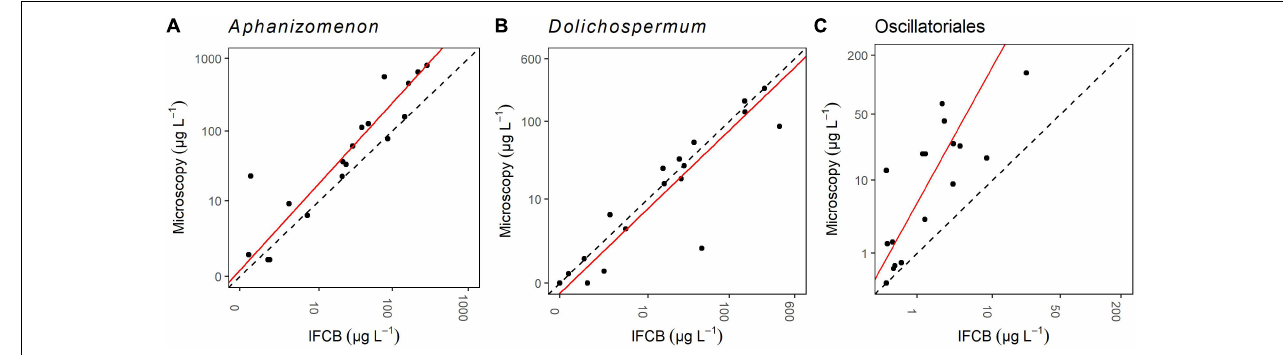
FIGURE 4 | Orthogonal regressions for comparison of light microscopy and IFCB biomass ( µ g L − 1 ) results for Aphanizomenon (A) , Dolichospermum (B) and Oscillatoriales (C) . The data are log(x + 1) transformed. The regression line is the red line and the 1:1 reference line is the black dashed